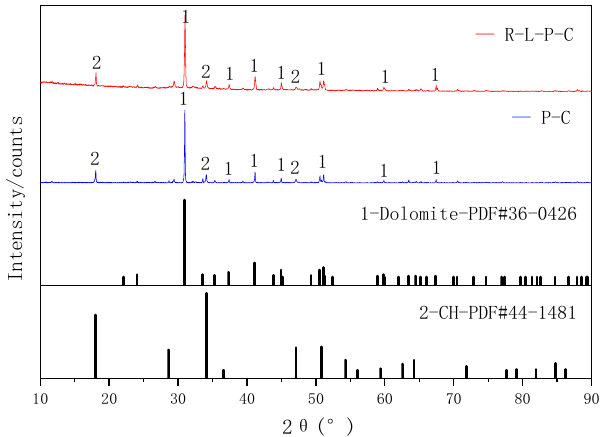
Figure 9. XRD patterns of the reaction product between dolomite aggregate and cement materials (1: dolomite (CaMg(CO 3 ) 2 ), 2: CH (Ca(OH) 2 )).